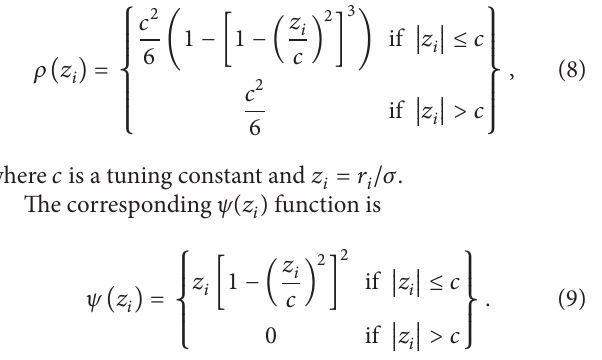
algorithm computes the residuals 𝑟